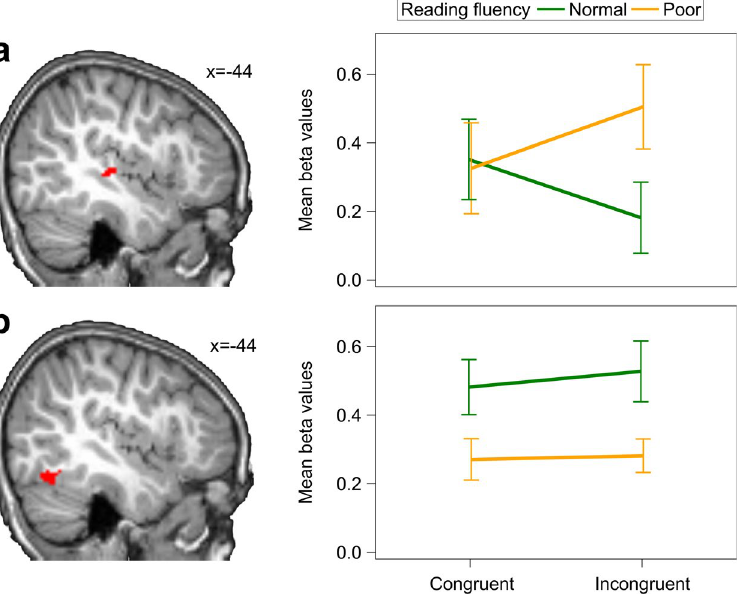
Figure 4. fMRI analyses. Mean beta values were extracted from the region of interests (ROI) projected onto a paediatric structural T1 image normalized to MNI space ( n = 28). Error bars illustrate standard error of the mean. ( a ) Interaction of congruency and future reading fluency in the left planum temporale (PT). The ROI was defined based on temporoparietal activation over both conditions and groups, and spatially restricted by a 12 mm radius sphere of the PT (center MNI coordinates: x = − 44, y = − 27, z = 13 18 ). ( b ) Main effect of reading fluency in the left ventral occipitotemporal cortex (vOT). The ROI was defined based on occipitotemporal activation over both conditions and groups and spatially restricted by the anatomical boundaries of the fusiform gyrus and a 12 mm radius sphere of the vOT (center MNI coordinates: x = − 44, y = − 57, z = − 15 44